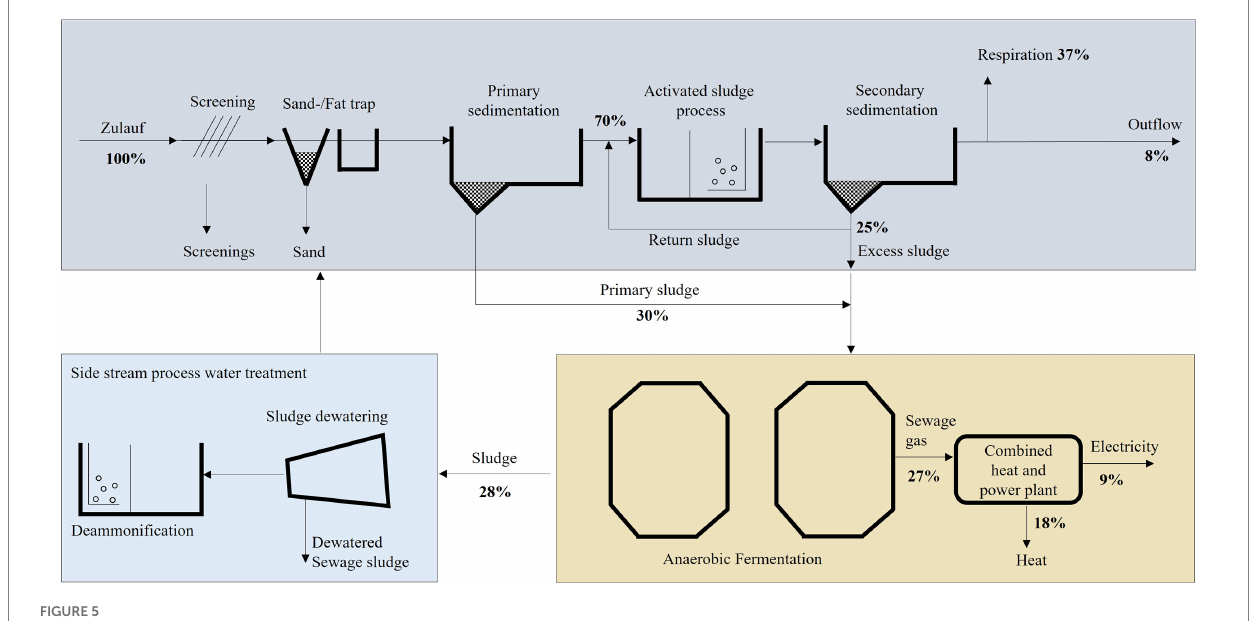
denitrification and mainstream deammonification is shown in Figure 7. The total investment for the new construction of MWWTP with mainstream deammonification is 1.98 Mio. € higher than the conventional plant with upstream